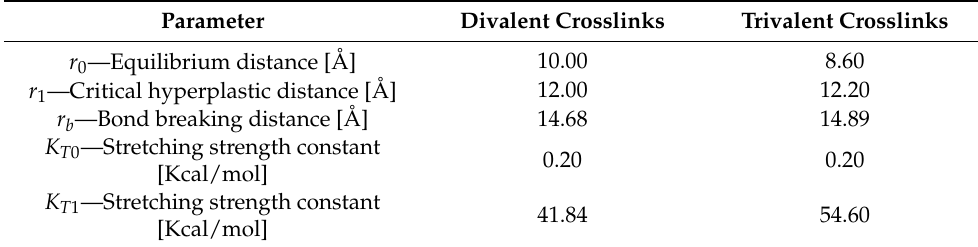
Table 4. Energy parameters of enzymatic